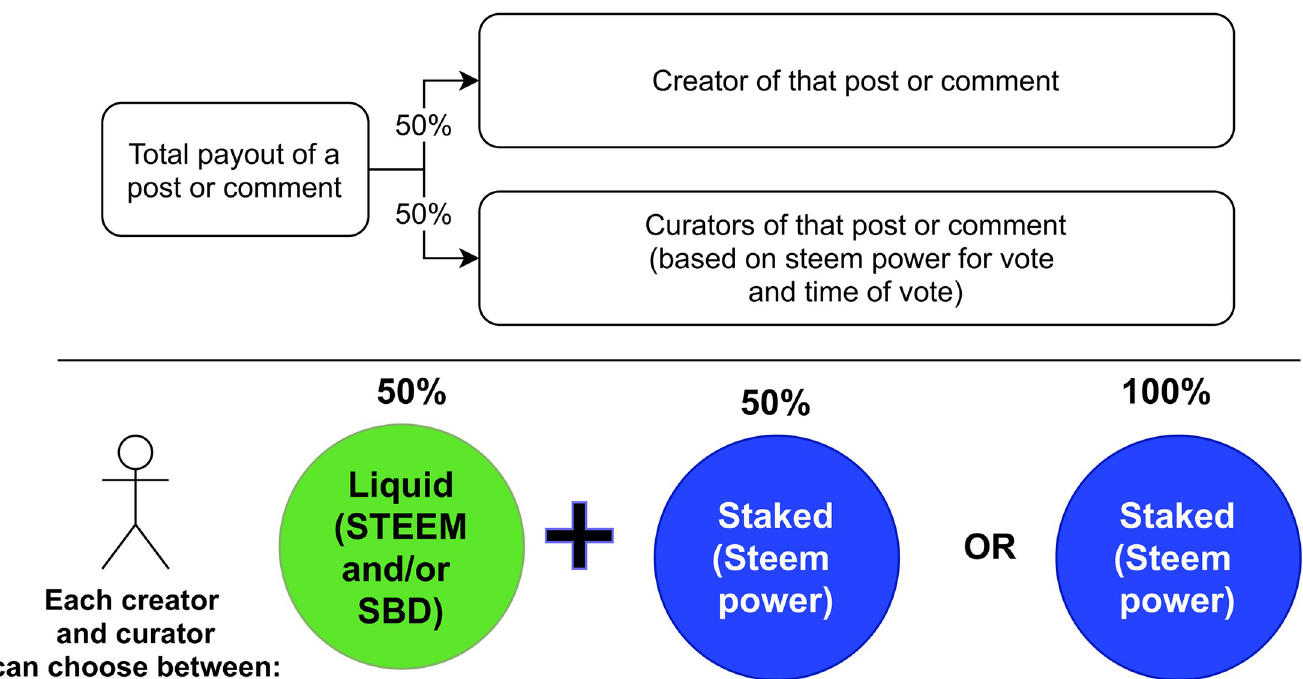
Fig 2. Allocation of the content payout pool. Summary of the allocation of the content payout pool between creator and curators. On top, the distribution of the rewards between the creator and curators. On the bottom, rewards can be received in two ways: full amount as Steem Power or as 50/50 split in STEEM/SBD and Steem